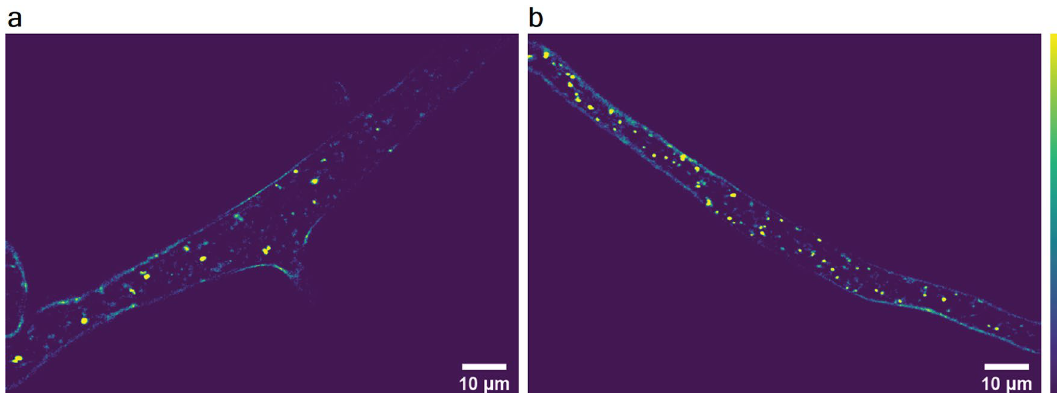
Figure 5. THG images of N-starved hyphae. ( a ) control hyphae; ( b ) N-starved (4.5 h duration of growth in nitrogen-depleted conditions). Both images were taken with Zeiss 40 × 1.3 objective lens whilst average laser power at sample plane was 24 mW (in A) and 20 mW (in B). Violet-lowest THG signal, yellow—highest THG